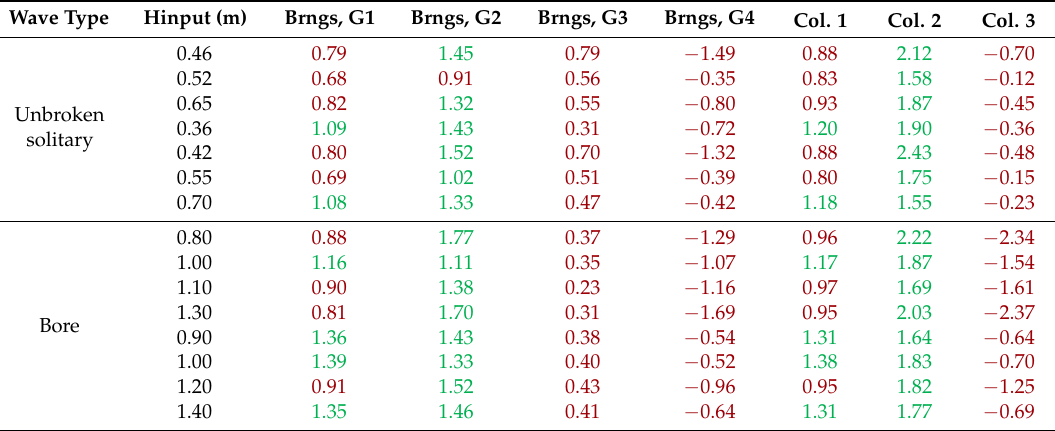
Table 6. Ratios of bearing and column-bent cap connection uplift forces calculated from load case 2 of the improved method to the respective values recorded in the